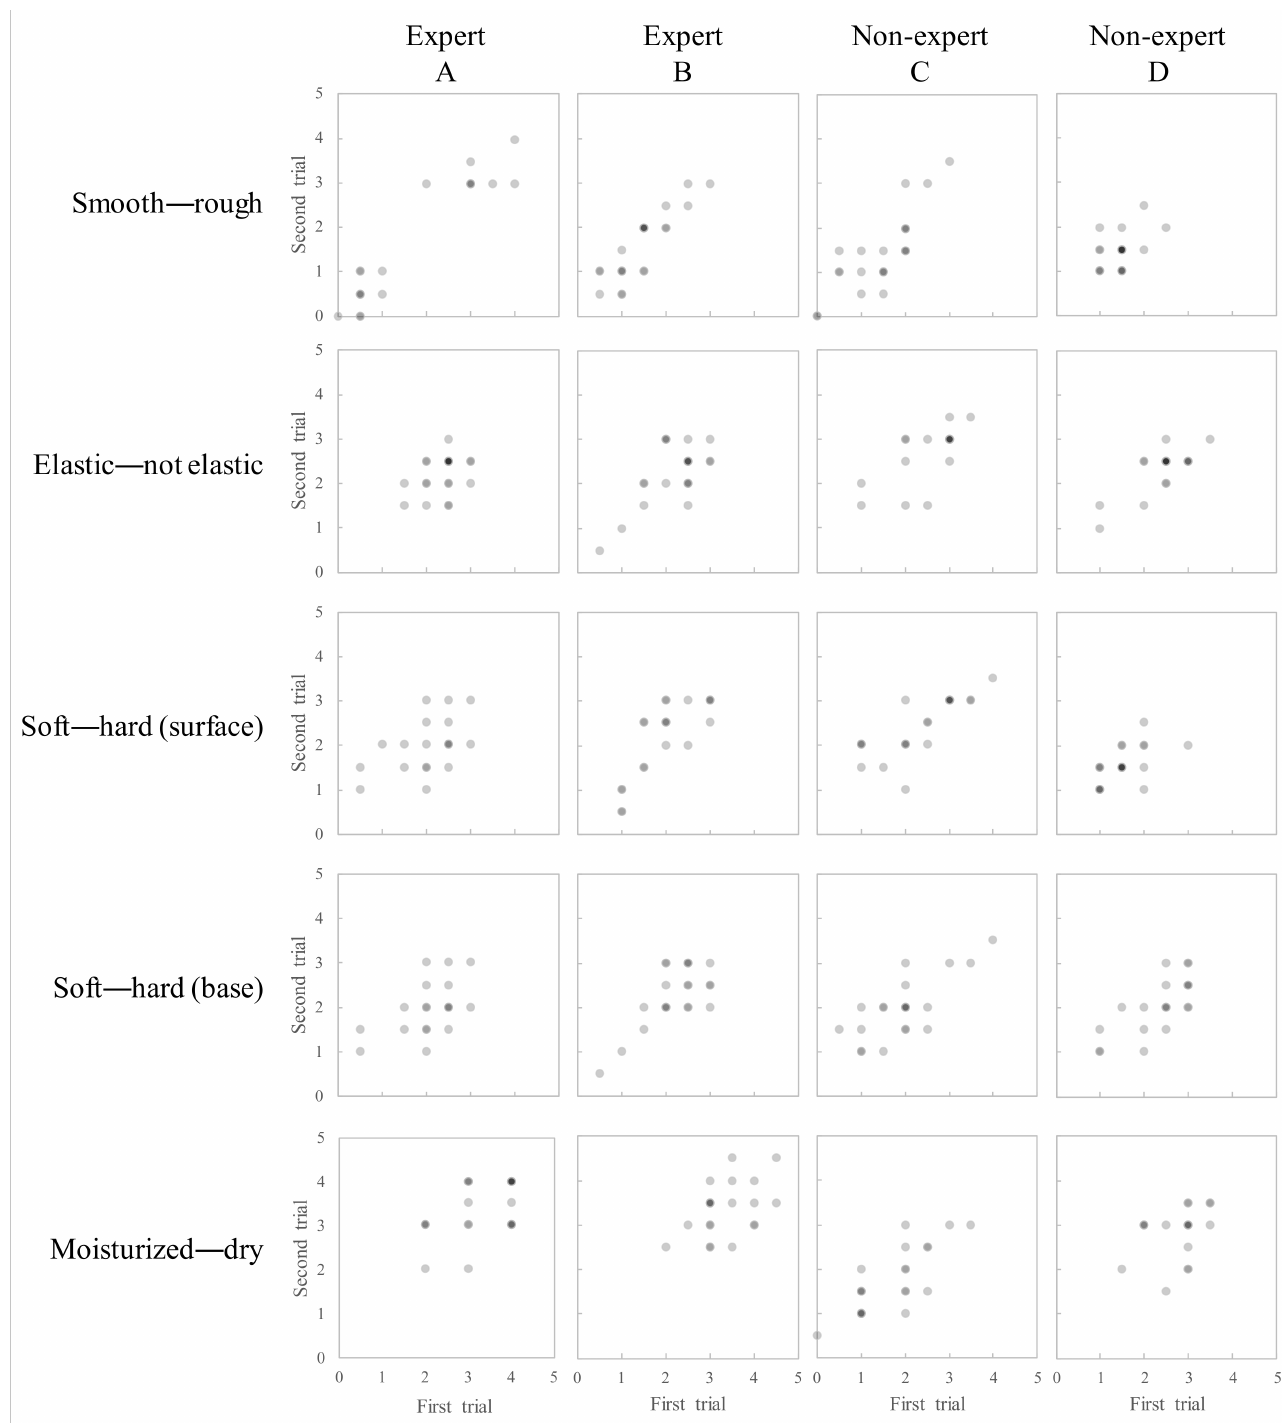
Figure 2. Scatter plots of sensory appraisal scores between the first and second trials for each combination of the panel and attribute. The columns show four assessors: A, B, C, and D. A and B are trained and C and D are non-trained. The rows show the five assessment items. The horizontal axis of each scatter plot represents the first assessment, and the vertical axis represents the second assessment. The shading of the points indicates the density; a darker shading indicates that more samples are gathered at that